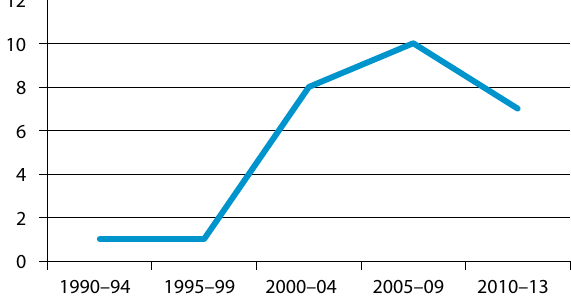
fig. 3. Dynamics of doctoral dissertations prepared